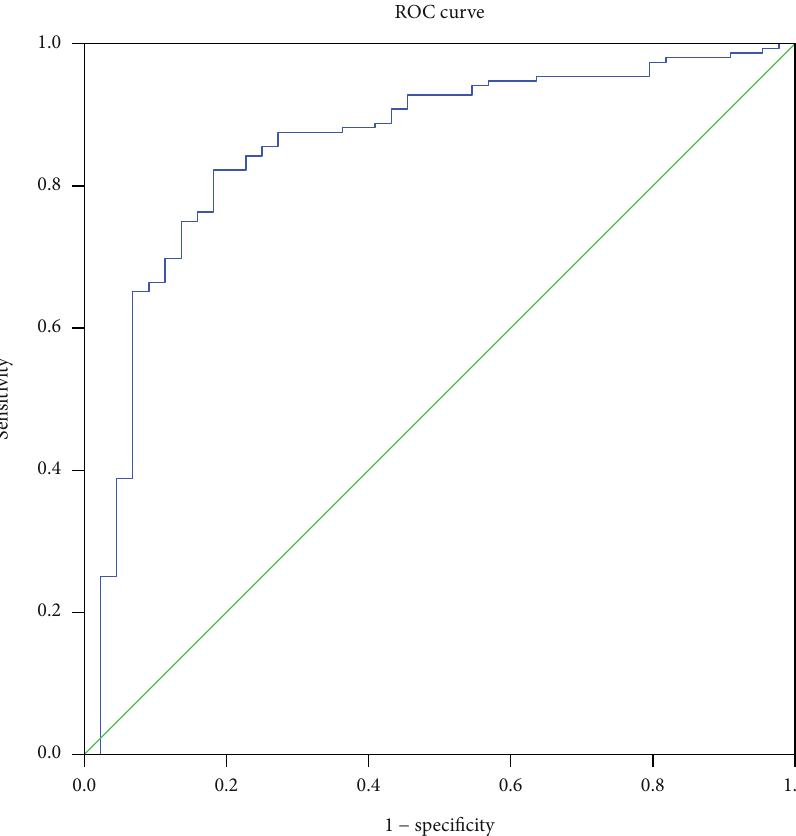
Figure 2: ROC curves for IDO in predicting